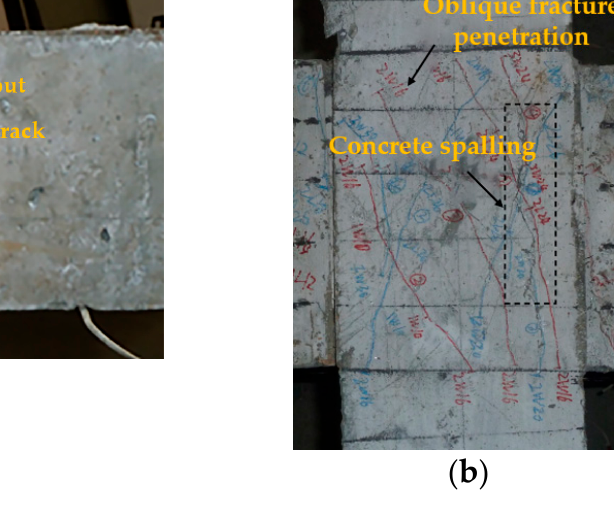
Figure 5. Final failure mode in the joint core area: ( a ) BFF; ( b ) JSF.